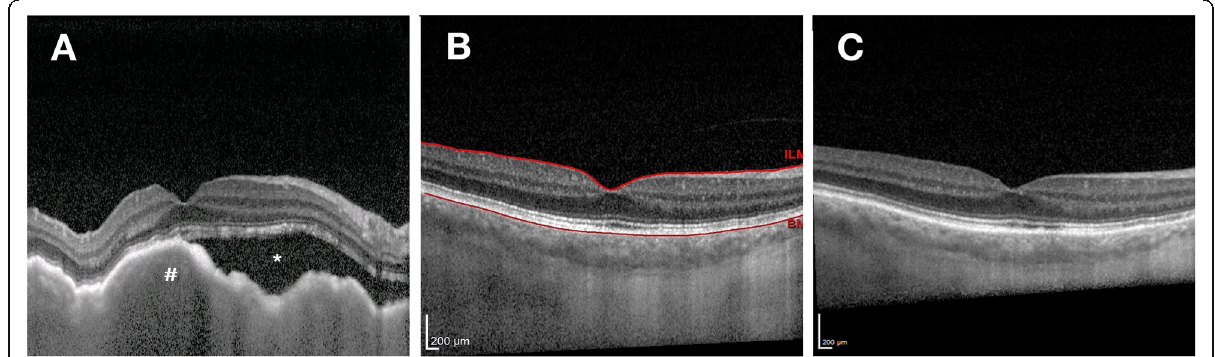
Fig. 4 EDI-OCT of right eye. ( a ) prior to radiotherapy; and b ) 6 months following ultra-low dose EBRT and cataract surgery c ) 12 months following ultra-low dose EBRT and cataract surgery. EDI-OCT= enhanced depth imaging optical coherence tomography; EBRT = External Beam Radiotherapy; * = subretinal fluid; # = choroidal